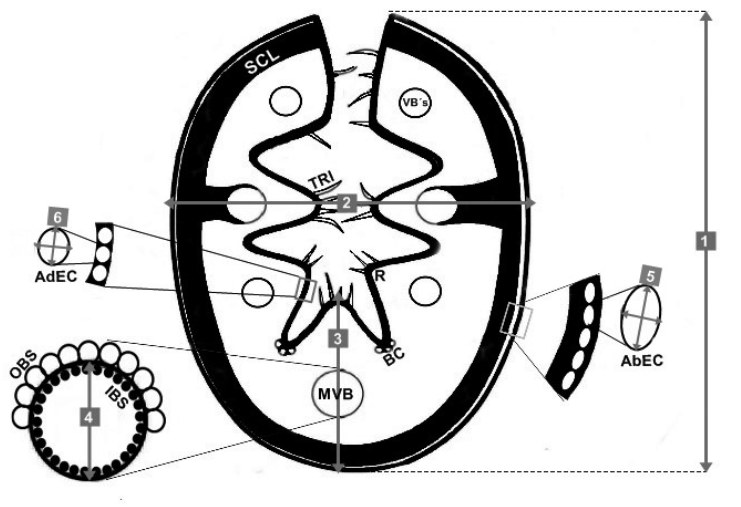
Figure 1. Main characters observed in the leaf cross-sections and abbreviations. Lines in grey indicate measures: 1 length (only in species with conduplicate blades) 2 maximum width 3 thickness of the blade at the midrib 4 maximum size/diameter of the median vascular bundle ( MVB ) 5 length × width of ab- axial epidermal cells ( AbEC ) 6 length × width of adaxial epidermal cells ( AdEC ). Sclerenchyma ( SCL ); vascular bundles ( VB’s ); ribs ( R ); trichomes ( TRI ); outer bundle sheath cells ( OBS ); and inner bundle sheath cells ( IBS